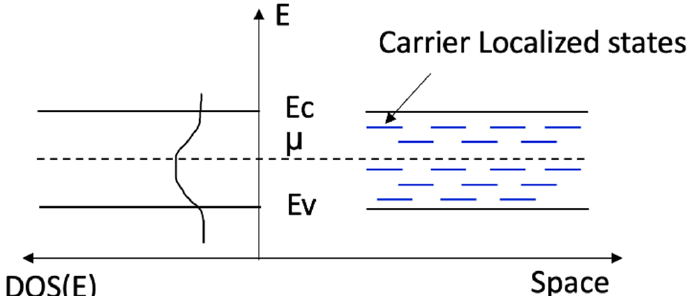
Figure 8. Sketch of the band diagrams and density of states as a function of energy for an amorphous material. Ec, Ev, μ and DOS(E) represent: conduction band energy, valence band energy, chemical potential and the density of the state, respectively.